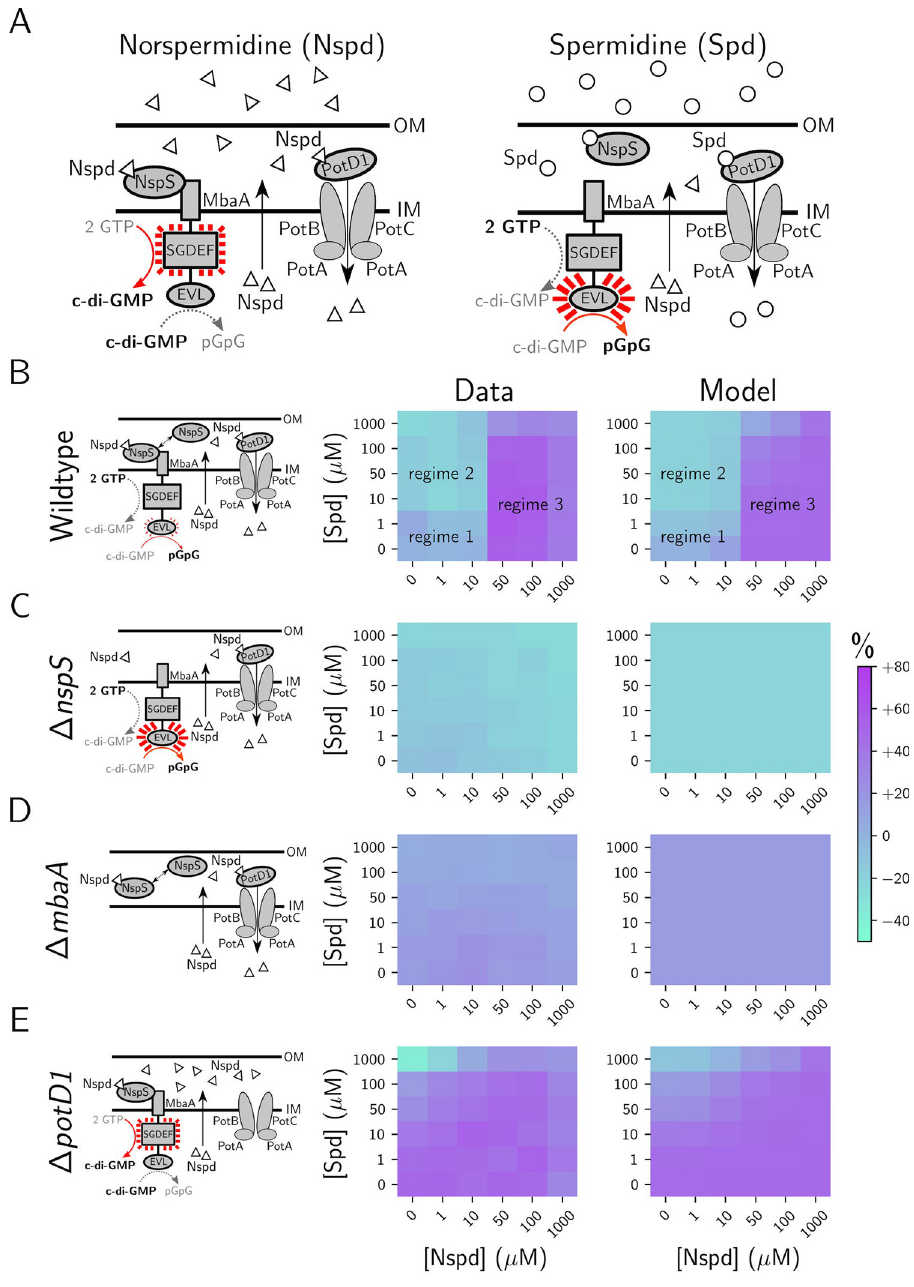
Fig 1. Modeling of polyamine sources, transport, and detection by the NspS-MbaA circuit captures in vivo dynamics. (A) Scheme for the NspS-MbaA c-di-GMP polyamine signal transduction circuit. V . cholerae detects periplasmic Nspd and Spd via the NspS-MbaA signaling system. Left panel: Detection of Nspd by the periplasmic binding protein NspS drives its association with MbaA, promoting MbaA diguanylate cyclase activity and biofilm formation. Nspd is exported to the V . cholerae periplasm via an unknown mechanism and is reimported by the PotABCD1 system. Right panel: When Nspd is absent, or when Spd is detected, NspS dissociates from MbaA and MbaA functions as a c-di-GMP phosphodiesterase, biofilm formation is repressed, and biofilm dispersal is promoted. Nspd is produced by Vibrionaceae . Spd is a commonly produced polyamine but is not substantially produced by V . cholerae . In MbaA, the GGDEF and EAL domains have the sequences SGDEF and EVL, respectively. MbaA was previously shown to possess both diguanylate cyclase and phosphodiesterase activities [16]. (B) Left panel: schematic of the periplasmic polyamine sensing and import components in wild-type V . cholerae in the absence of exogenous polyamines. Middle panel: experimentally obtained results for c-di-GMP reporter output in wild-type V . cholerae for